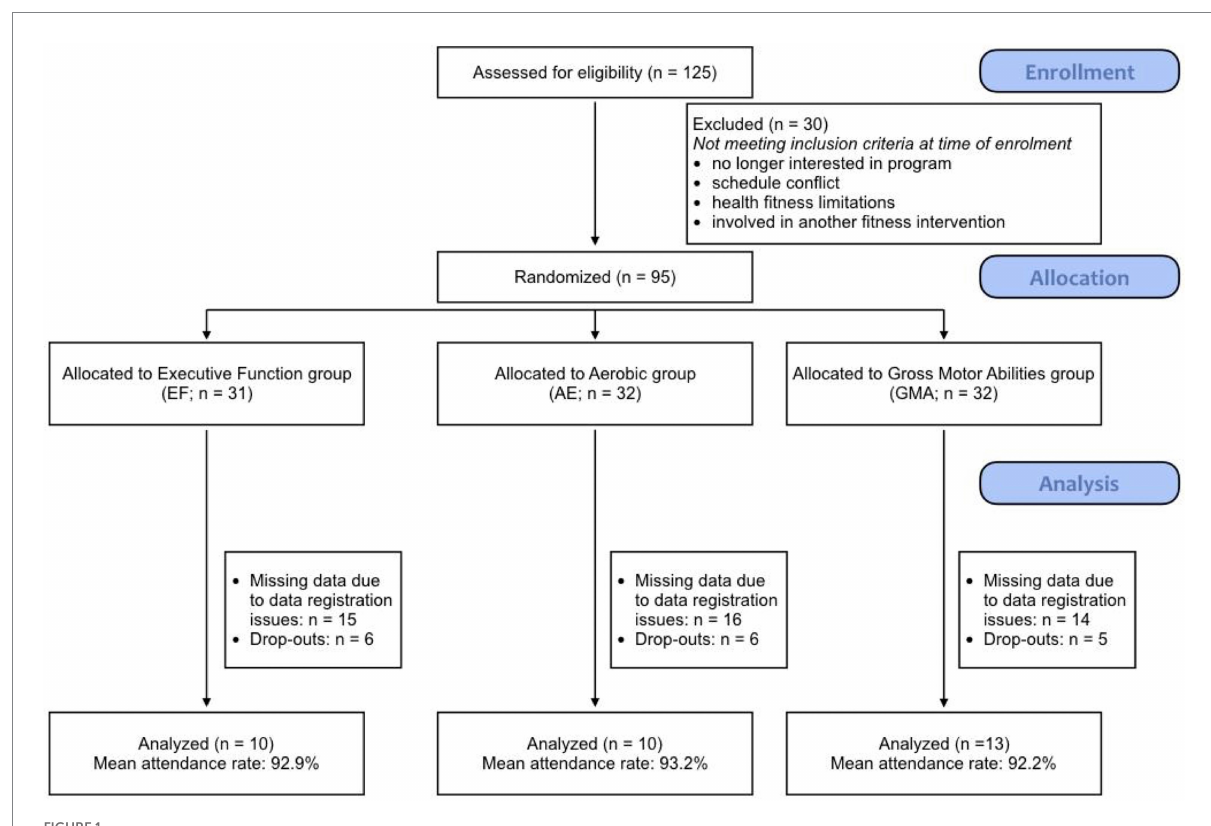
FIGURE 1 CONSORT flow diagram. Note: The final row depicts the number of participants included in the